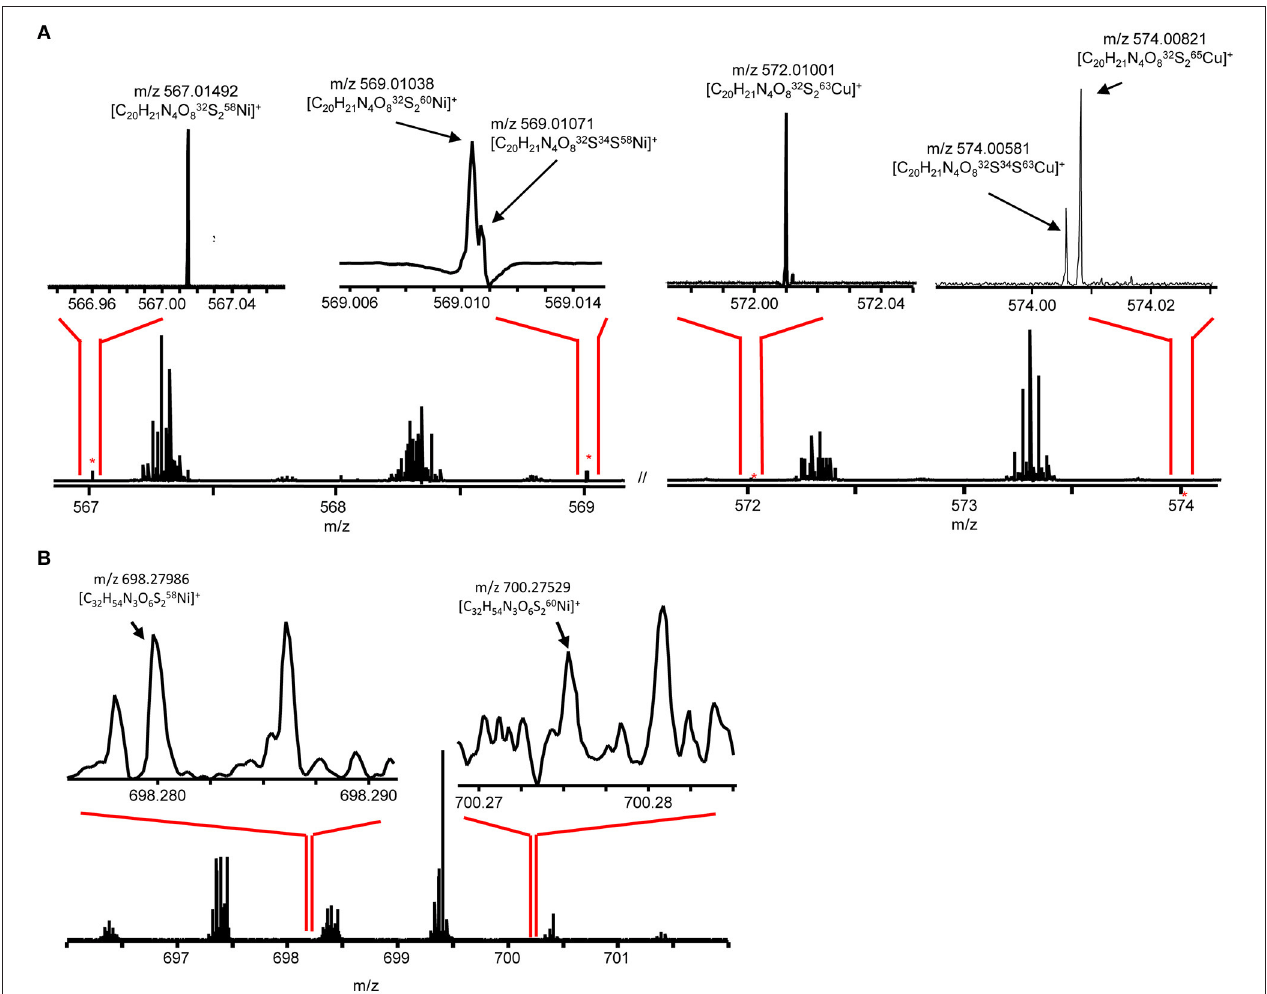
FIGURE 6 | Direct infusion ESI FT-ICR MS at 9.4 Tesla of (A) compound a and (B) compound c . Major isotopologues are